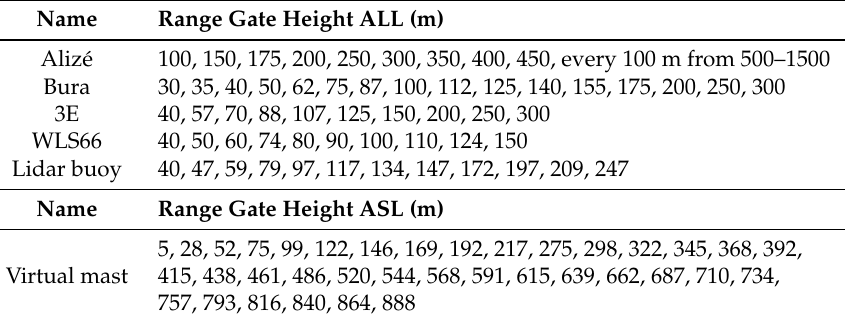
Table 3. The heights of the range gates of the VAD lidars and those of the virtual mast scenario.